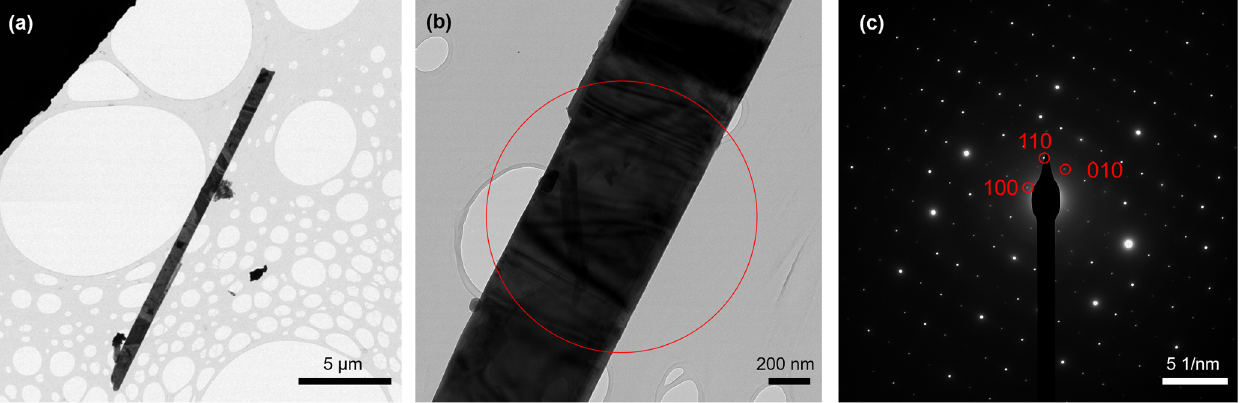
Figure 3. ( a , b ) TEM images of the ZrSe 3 sample after liquid-phase exfoliation. The circle in ( b ) indi- cates the region for electron diffraction. ( c ) The corresponding SAED pattern obtained along [001] zone axis.